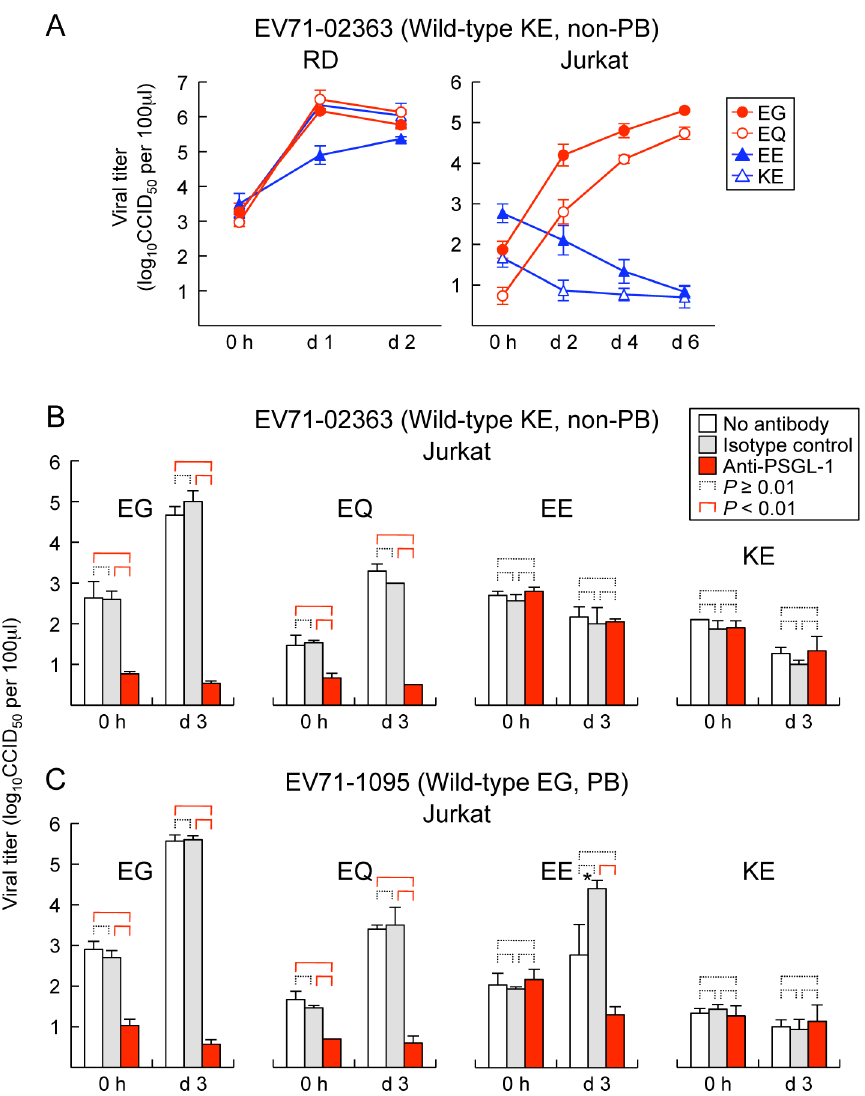
Figure 2. Replication of EV71 mutants in RD and Jurkat cells. (A) RD (left) or Jurkat (right) cells were infected with EV71-02363 mutants at 1 CCID 50 per cell for 1 h, then washed, cultured, and harvested at the indicated days (d) post-infection. (B, C) EV71 replication in Jurkat cells incubated with anti-PSGL-1 mAb and isotype control. Cells were pretreated with antibodies for 1 h and then infected with 1 CCID 50 per cell for 1 h, washed, cultured, and harvested at 3 days (d) post-infection. Viral titers are expressed as the mean, and error bars indicate s. d. for triplicate samples. (B) EV71- 02363. (C) EV71-1095. Although arise in viral titer was observed for EV71-1095-EE at day 3 (asterisk), the recovered viruses were VP1-145E to